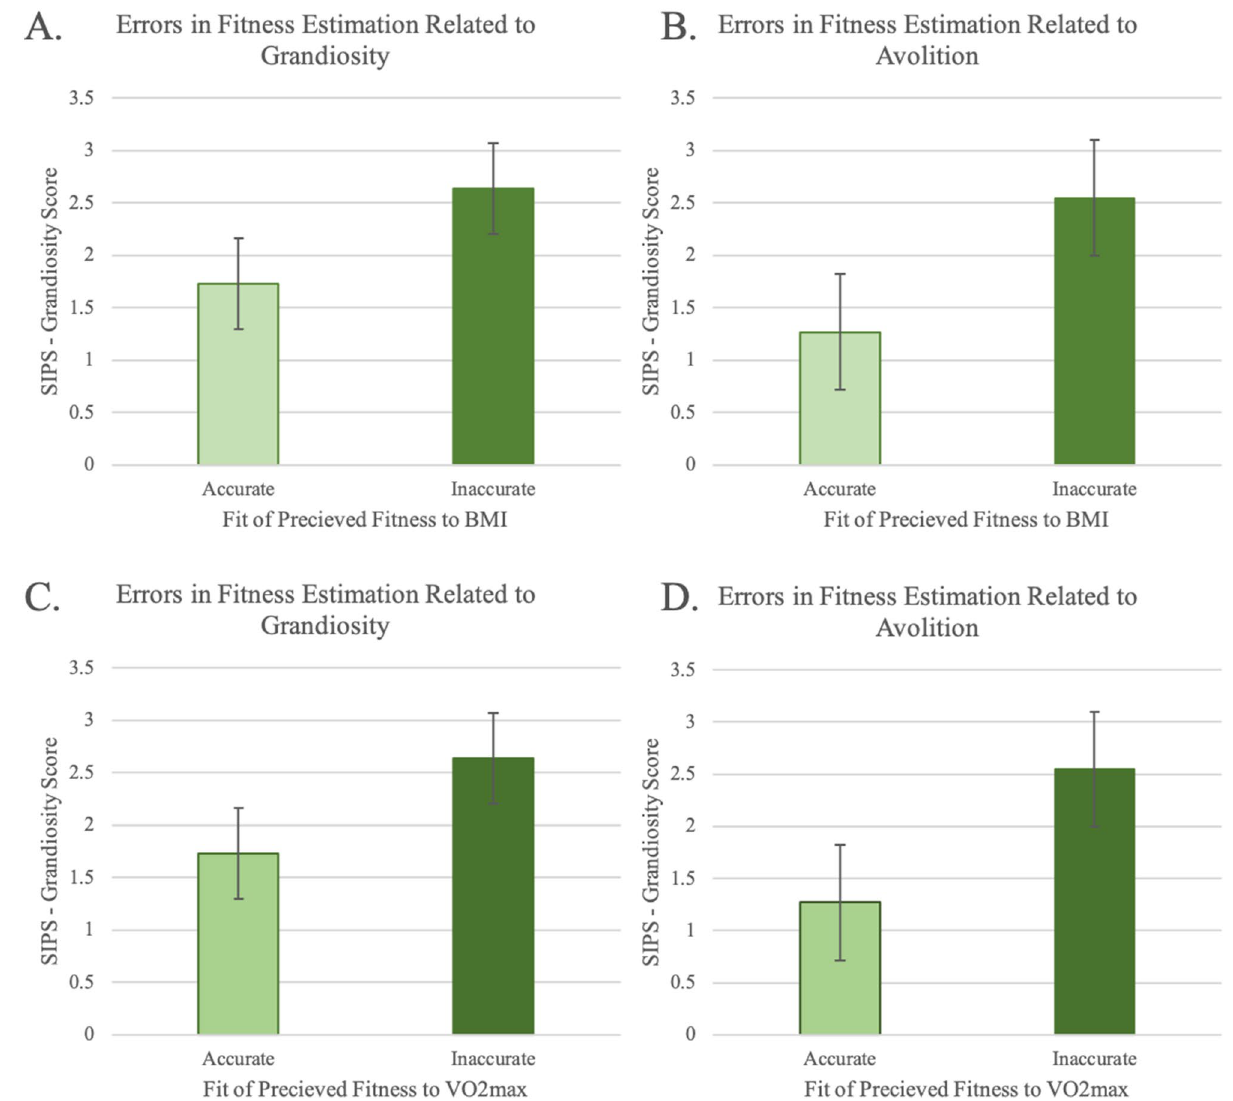
Figure 3. Errors in perception related quartiles groups (inaccurate and accurate) for BMI (top panels) and VO 2 max (bottom panels) to symptoms of (A,C) grandiosity and (B,D)